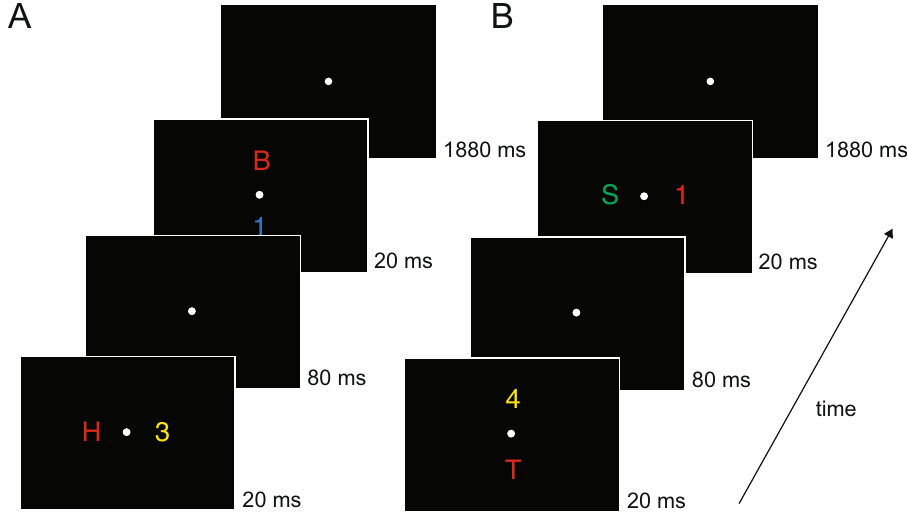
Figure 1. Example trial time lines of Experiment 1. There were two types of trials: the first display contained items on the horizontal axis and the second display items on the vertical axis ( A ), or the first display contained items on the vertical axis and the second display items on the horizontal axis ( B ). Subjects were required to determine whether a color-defined target was a digit or letter. The target color remained constant within a session (red in this example). Potential target colors were red, green, blue or yellow (counterbalanced across subjects). Within blocks, subjects either had to detect a target in the first display (D1 blocks) or they had to detect a target in the second display (D2 blocks). We only analyzed task relevant displays.